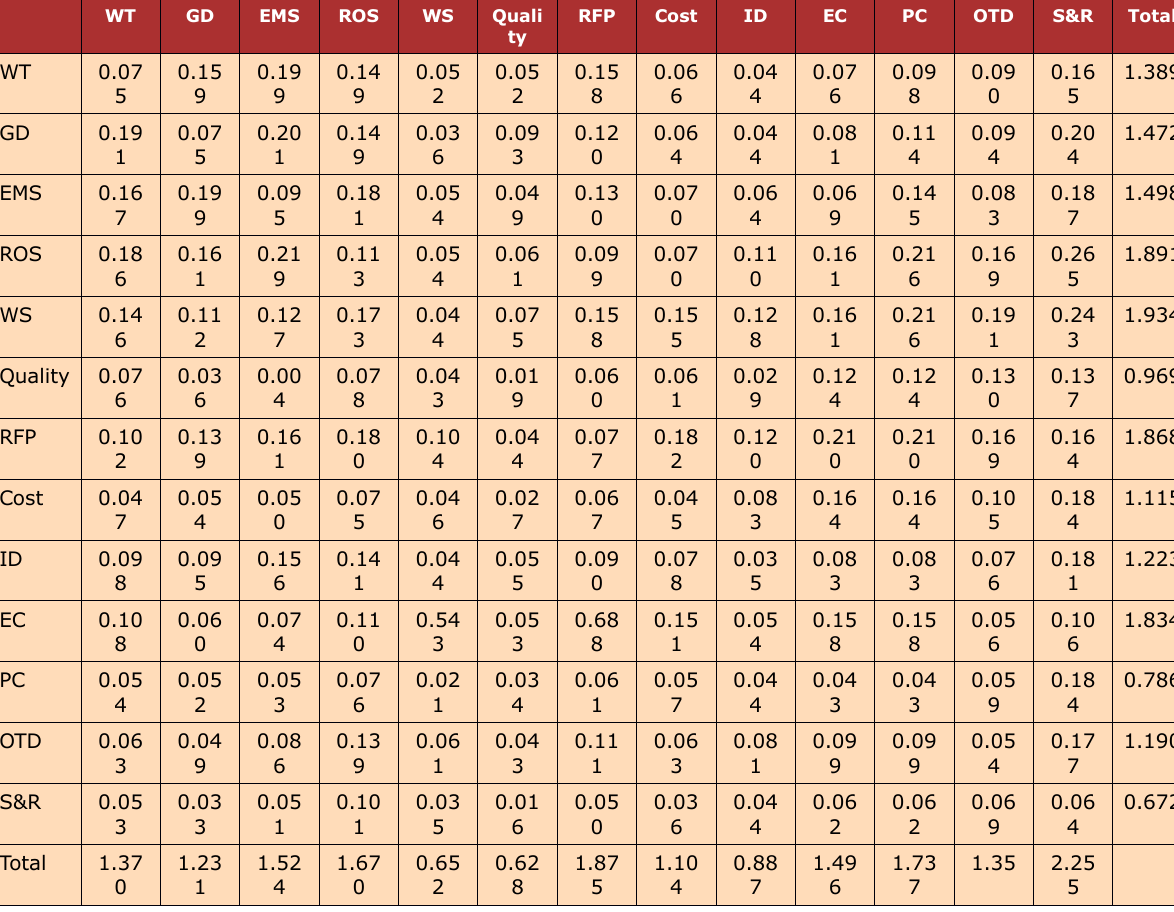
Table 10. Total- relation matrix